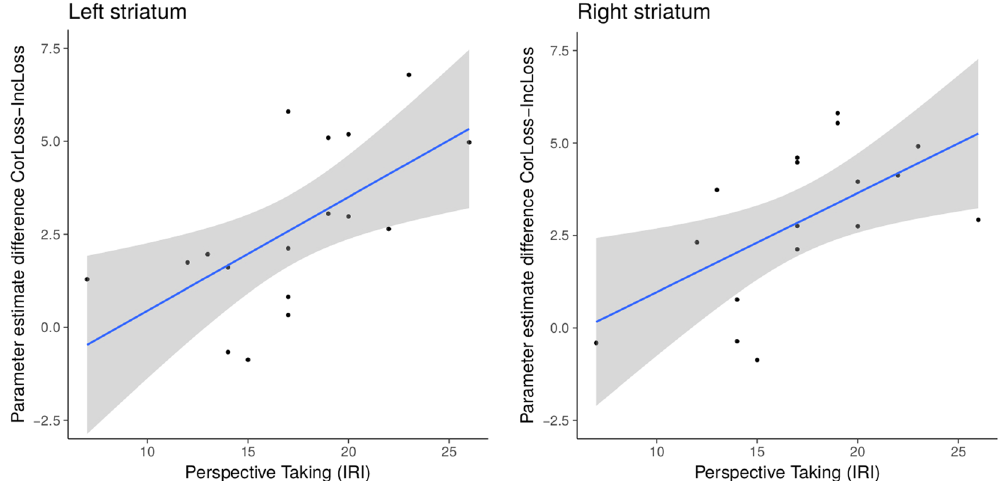
Figure 6. Correlation (with 95% confidence interval) between neural activation in the left and right striatum for beta-values in the contrast Correct-Loss > Incorrect-Loss and self-reported perspective taking (Interpersonal Reactivity Index). The ROI was based on the anatomical masks of the striatum (NAcc in specific) extracted from the Harvard-Oxford subcortical atlas